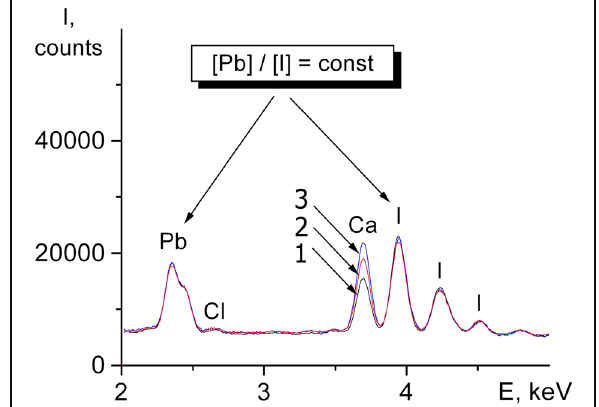
Fig. 3 EDX of CH 3 NH 3 PbI 2.98 Cl 0.02 films after heat treatment at 80 ° С and the ratio of starting reagents (PbI 2 and CH 3 NH 3 І ) 1:1 (1), 1:2 (2), and 1:3